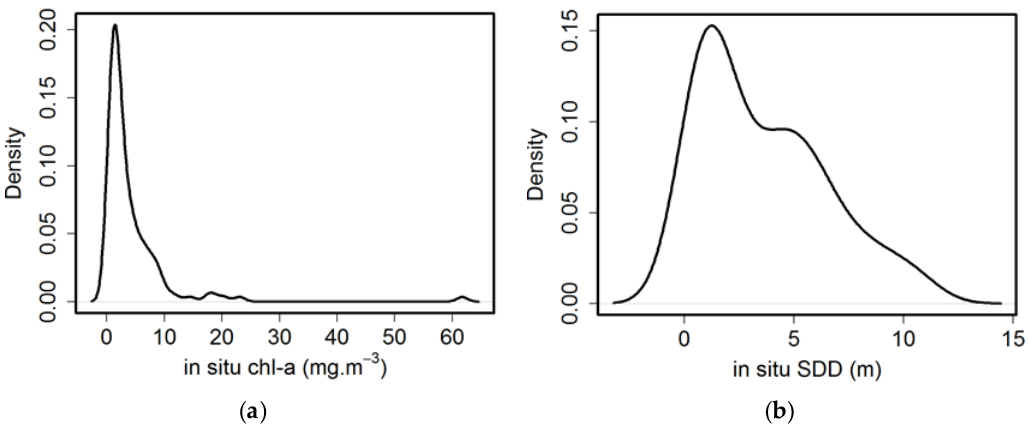
( d ) Figure 2. Relationships between in situ SDD and three bio-optical parameters of the water: chl-a ( a ); TSM ( b ); and a CDOM (440) ( c ); Relationship between in situ chl-a and in situ TSM is also shown ( d ). Based on the results presented in Table 3 and in Figure 2, Lake Erie can be classified as a typical Case II water system where other water constituents play a major and independent role in its low water clarity, besides chl-a concentration. Therefore, red and NIR reflectances are consistently the